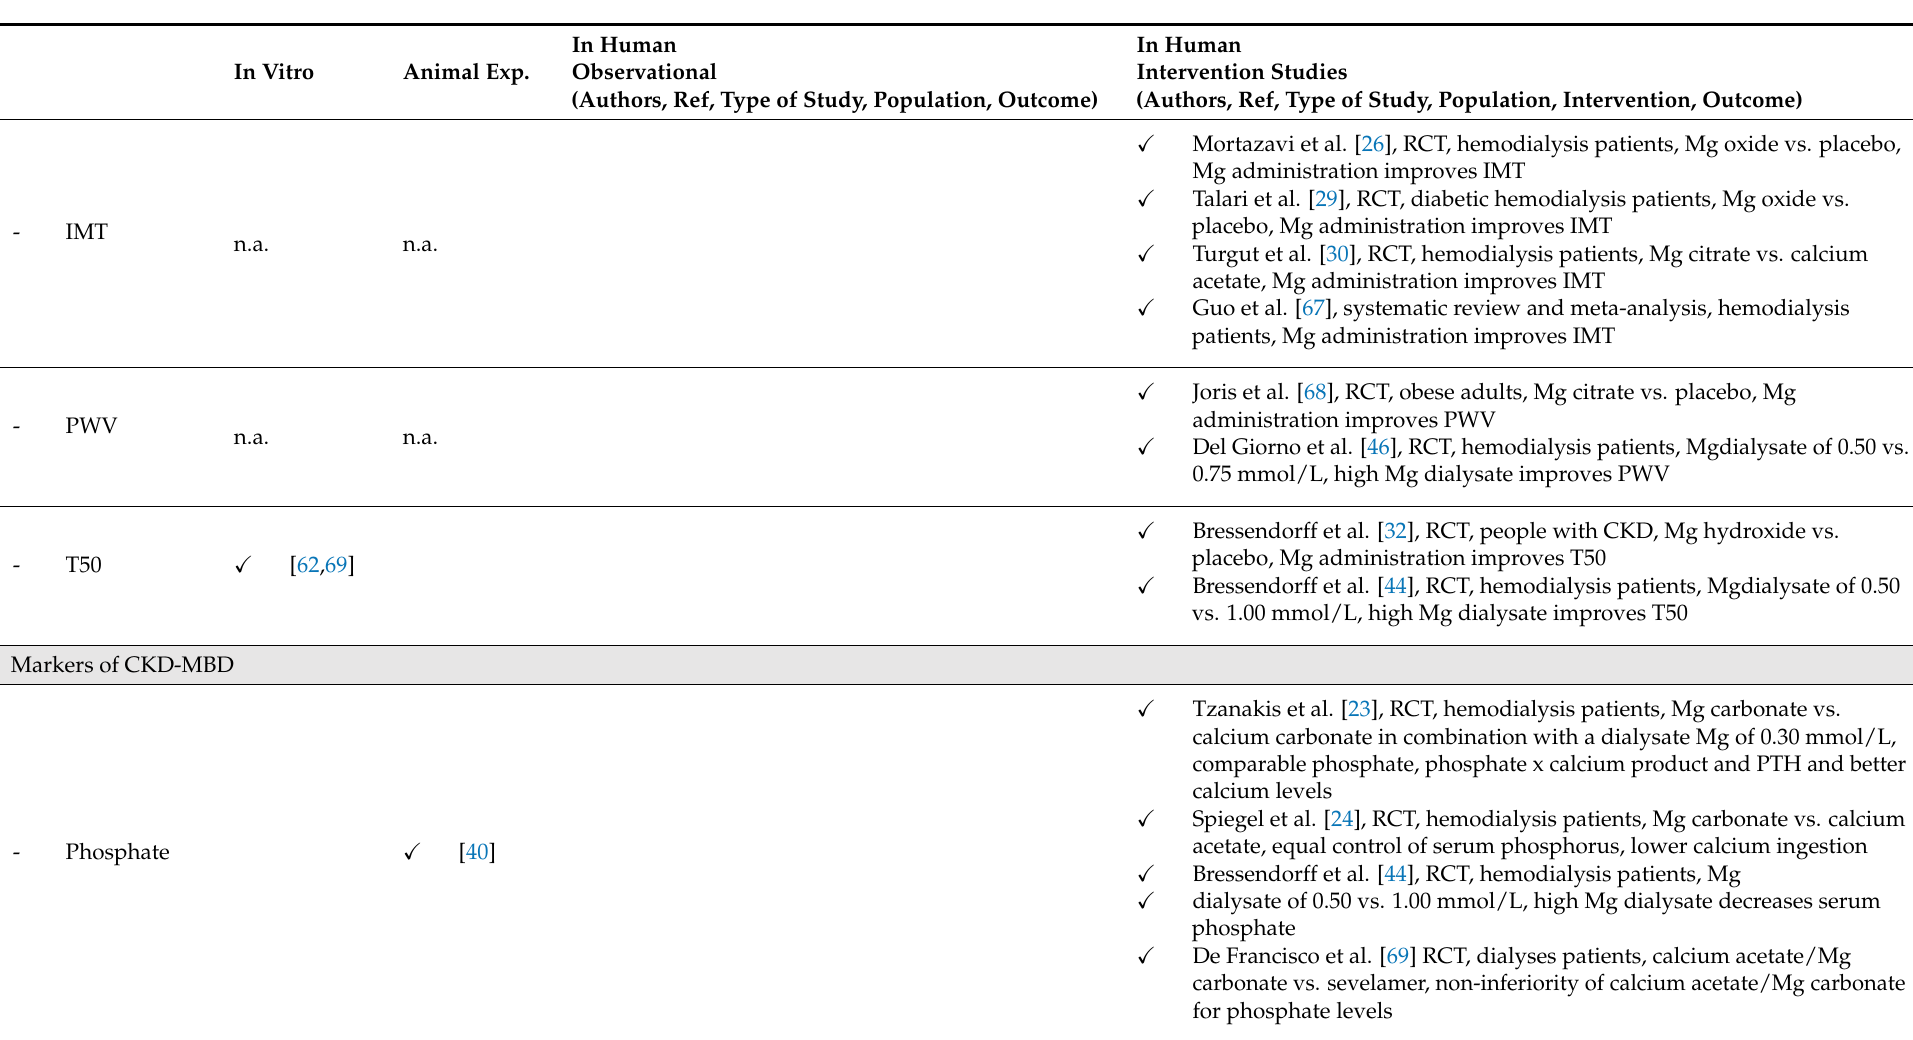
In Vitro Animal Exp.